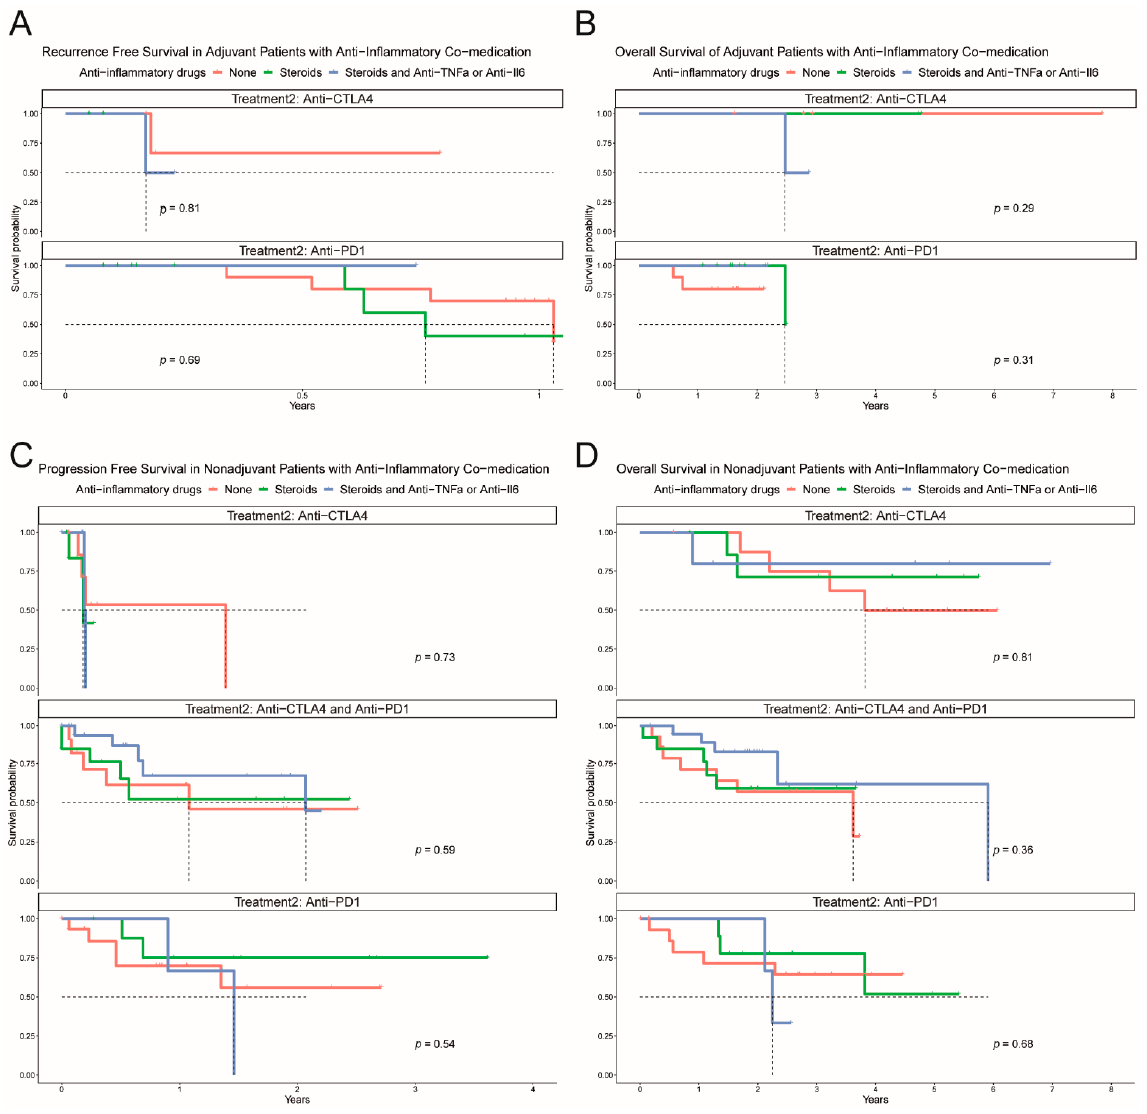
Figure 5. Kaplan–Meier plots for the adjuvant and non-adjuvant settings stratified by treatment for the irAE. ( A ) Recurrence-free survival in the adjuvant setting for anti-CTLA4 and anti-PD1. ( B ) Overall survival in the adjuvant setting for anti-CTLA4 and anti-PD1. ( C ) Progression-free survival in the non-adjuvant setting for anti-CTLA4, anti-PD1, and anti-CTLA4 with anti-PD1. ( D ) Overall survival in the non-adjuvant setting for anti-CTLA4, anti-PD1, and anti-CTLA4 with anti-PD1.